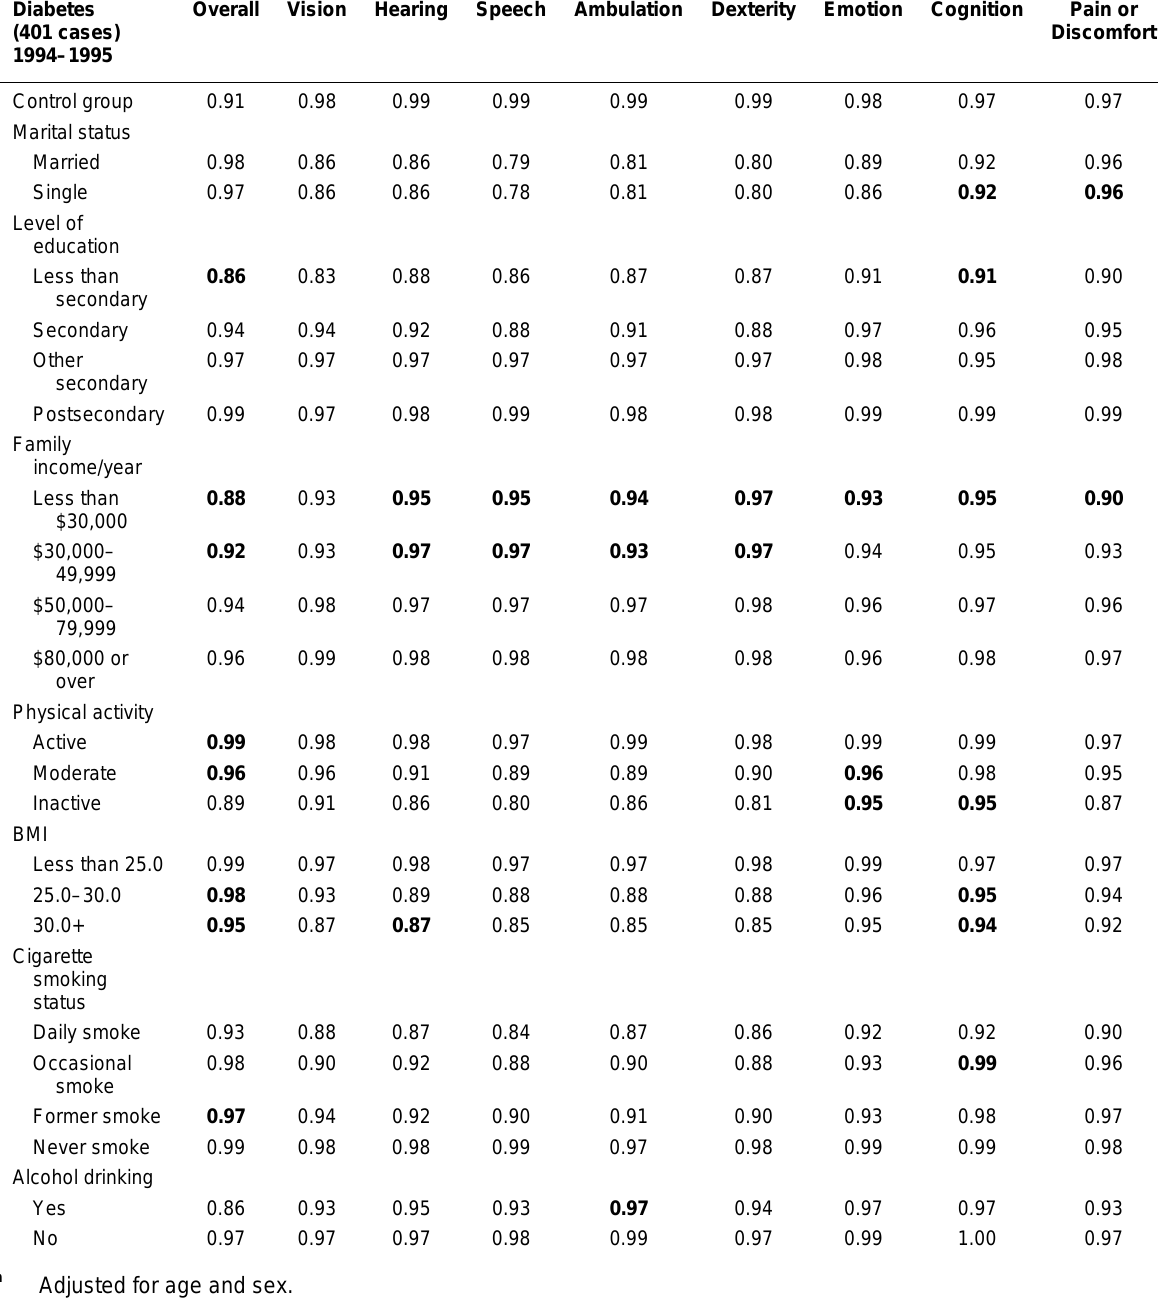
Adjusted Mean of Overall HUI3 and Single-Attribute Scores Related to Diabetes, NPHS Longitudinal Data, from 1994–2003